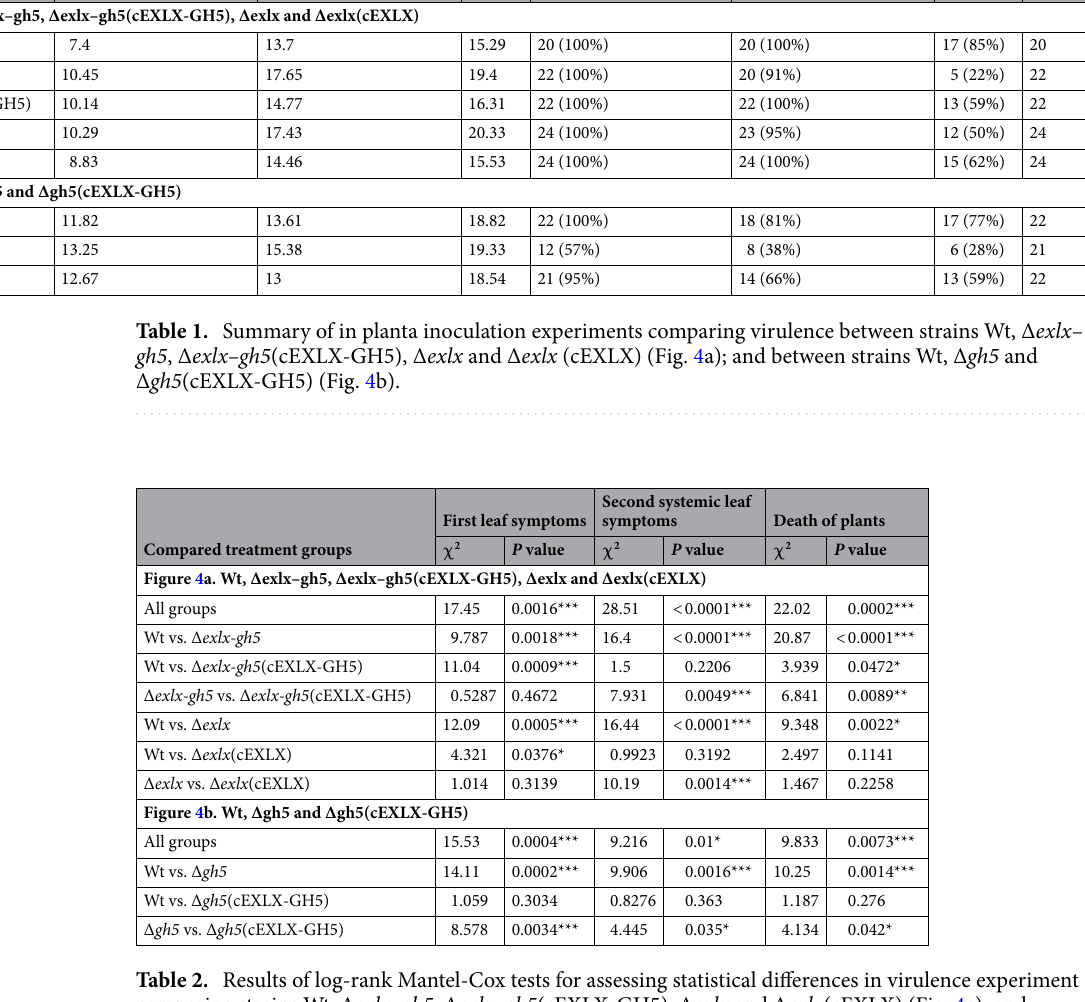
Table 2. Results of log-rank Mantel-Cox tests for assessing statistical differences in virulence experiment comparing strains Wt, Δ exlx–gh5 , Δ exlx–gh5 (cEXLX-GH5), Δ exlx and Δ exlx (cEXLX) (Fig. 4a); and comparing strains Wt, Δ gh5 and Δ gh5 (cEXLX-GH5) (Fig. 4b). *Significant at P < 0.05. **Significant at P < 0.01. ***Significant at P < 0.005.